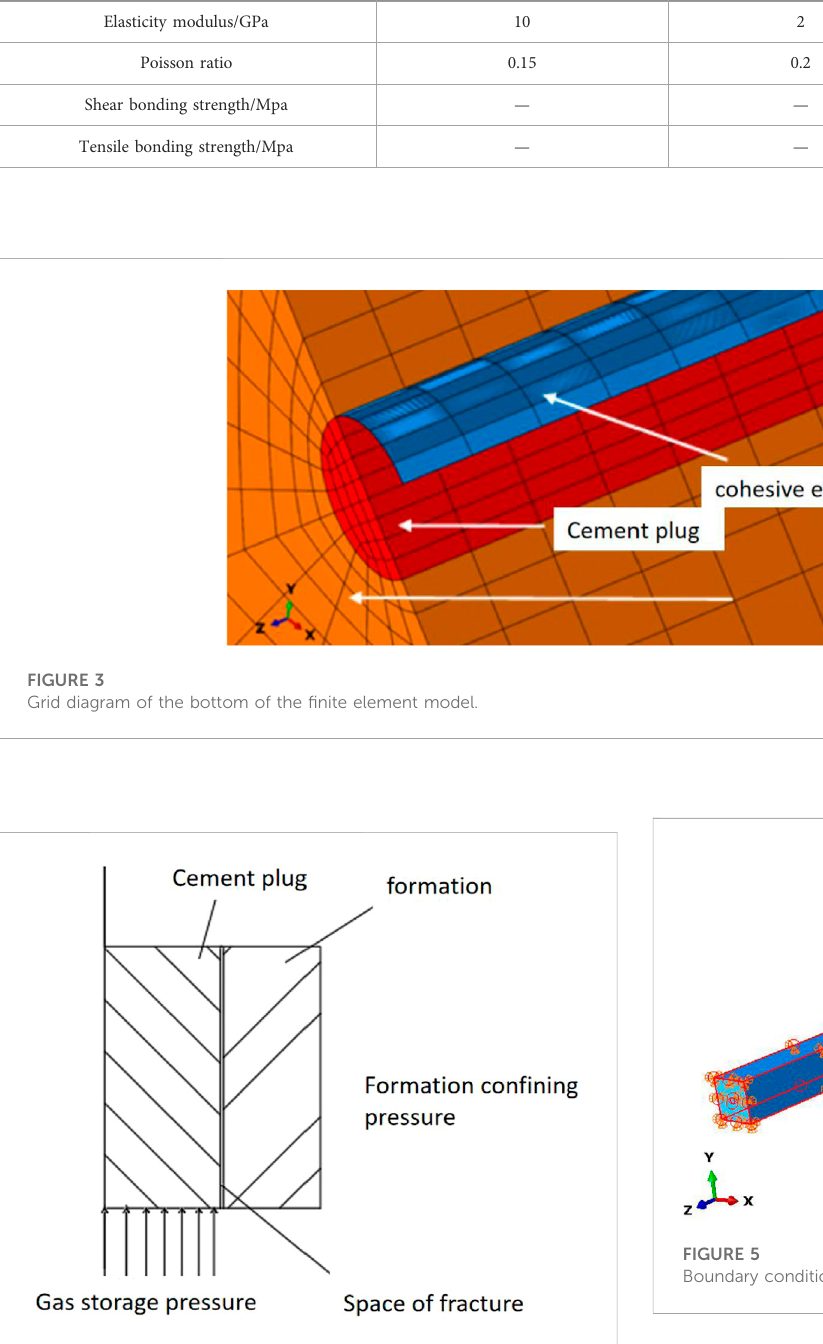
FIGURE 4 Schematic diagram of cement plug-formation interface subjected to gas storage pressure.